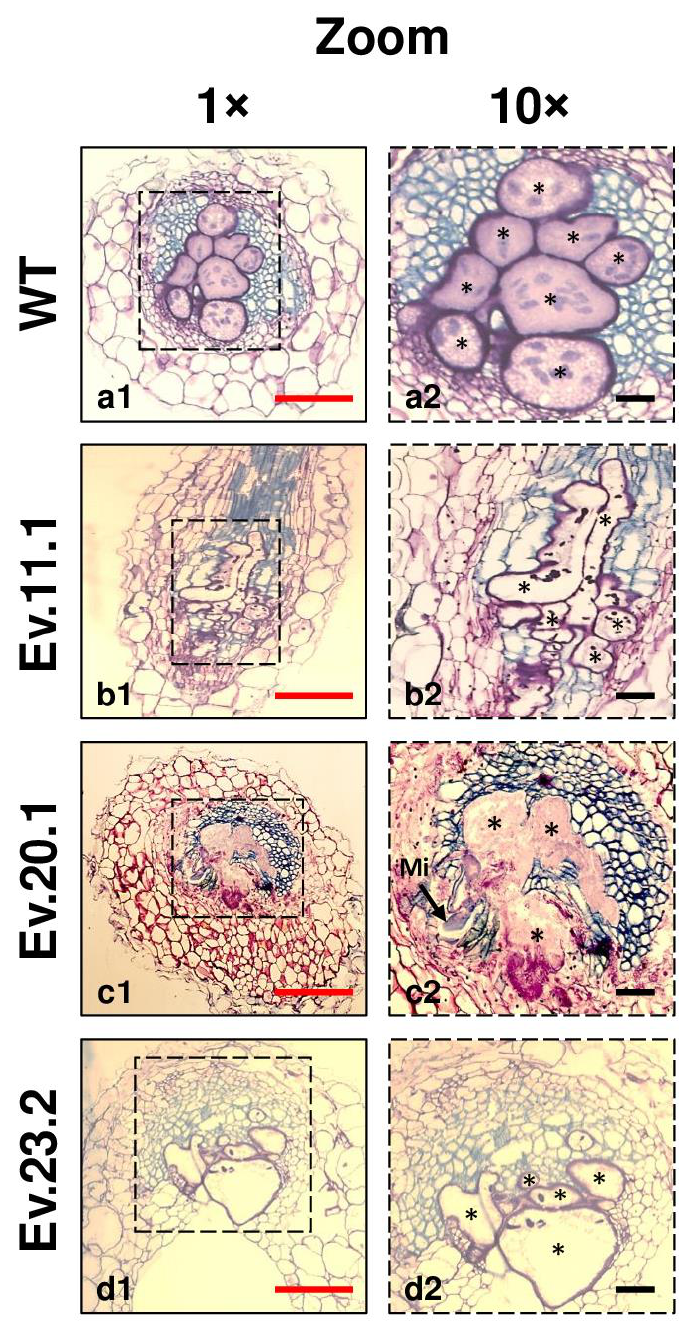
Figure 8. Histological analysis of M. incognita -induced galls in transgenic Nicotiana tabacum overex- pressing the soybean GmPR10 gene. At least five biological replicates from each line were infected with M. incognita, and gall and nematode morphology were evaluated 60 days after inoculation (DAI). ( a1 , a2 ) non-transformed wild-type (WT); ( b1 , b2 ) E11.1, ( c1 , c2 ) E20.1 and E23.2 ( d1 , d2 ). All sectioned galls were stained with toluidine blue. Gall from WT control presented multiple giant cells filled with dense cytoplasm and contained large nuclei. In contrast, galls from transgenic lines showed giant cells with few cytoplasm contents in E11.1 and E23.2 lines and, additionally, E20.1 line showed nematode with altered morphology and giant cells, which presented thinner cell walls. In this way, the analysis demonstrated that GmPR10 overexpression showed a direct effect on feeding site ontogeny. ( a1 – d1 ) zoom 1 × . ( a1 – d2 ) zoom 10 × . Legend: (*) giant cell ; (Mi) M. incognita. Scale bars: 50 µ m (red) and 2.5 µ m